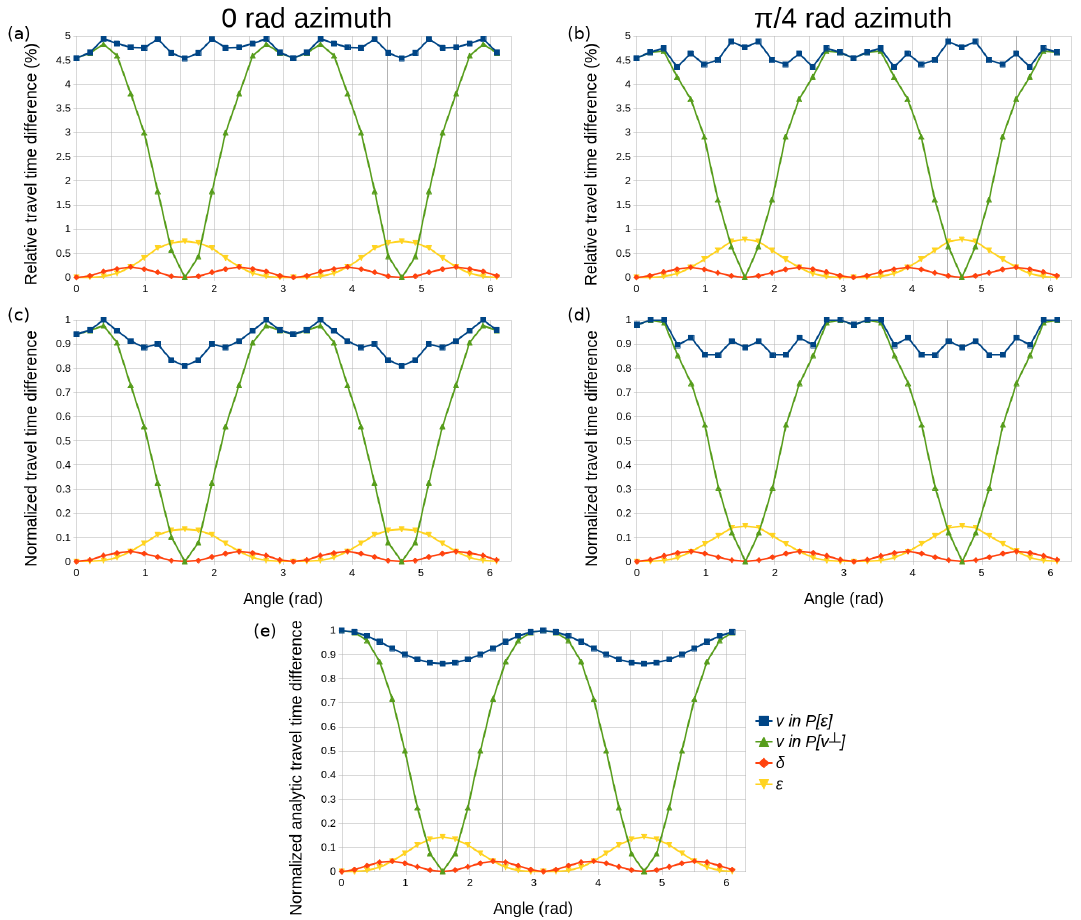
Figure 2. Sensitivities for the meridians at azimuths 0 rad (a, c) and π/ 4 rad (b, d) as a function of the polar angle (origin in the down- ward vertical axis). (a, b) Synthetic relative sensitivities in percentage, (c, d) synthetic normalized sensitivities and (e) normalized analytic sensitivities. Sensitivity values displayed correspond to all source–receiver pairs along the selected meridians of the acquisition